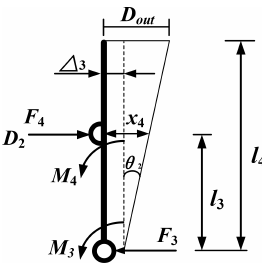
Figure 9. Analysis diagram of the vertical lever